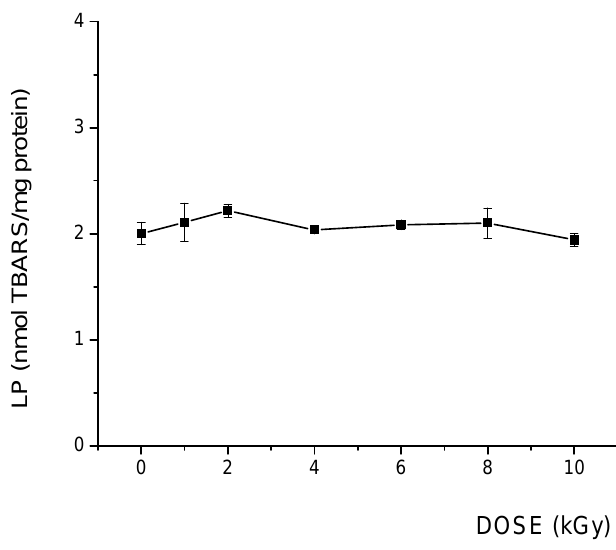
Figure 1. Effect γ -irradiation on LP intensity in soybean